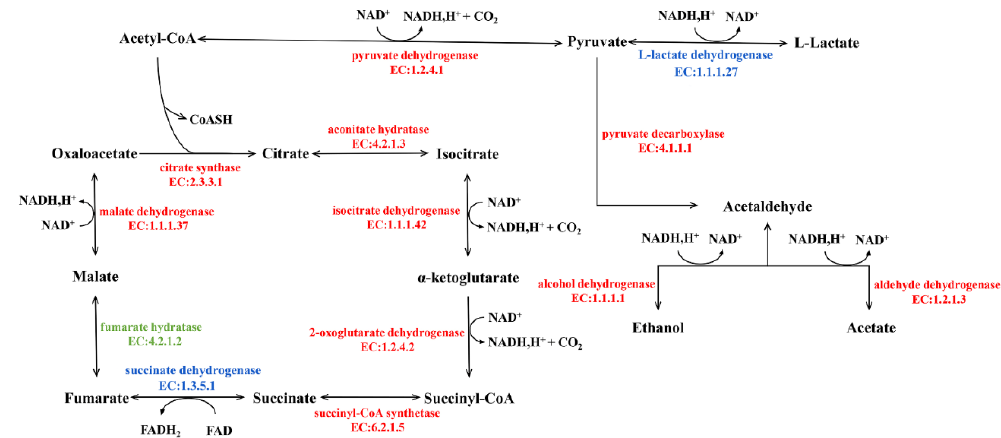
Figure 6. TCA-cycle of Mix vs Sq7, the enzymes coloured in blue represent upregulated, in red represent downregulated enzymes, in green represent the enzyme is no significant difference.